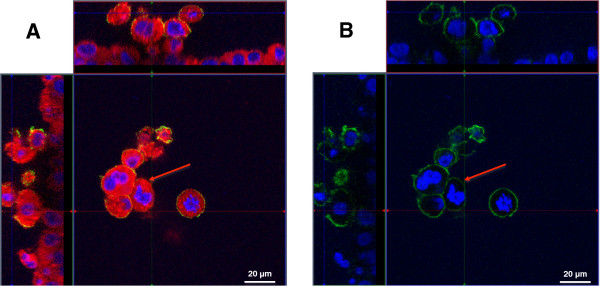
Colonies of differentiated THP-1 cells on top of epithelial A549 cells. A: Analysis of the distribution of THP-1 cells in the coculture system by a z-stack image series. THP-1 cells form colonies of several cells on top of A549 cells. THP-1 cells are stained with anti-CD11b-antibody (green); nuclei are counterstained with DAPI (blue). X–y projection with the respective side views (Magnification: 630x). B: Same image as shown in A but only with the channels for DAPI and CD11b. The red arrows indicate representative colonies (Magnification: 630x).